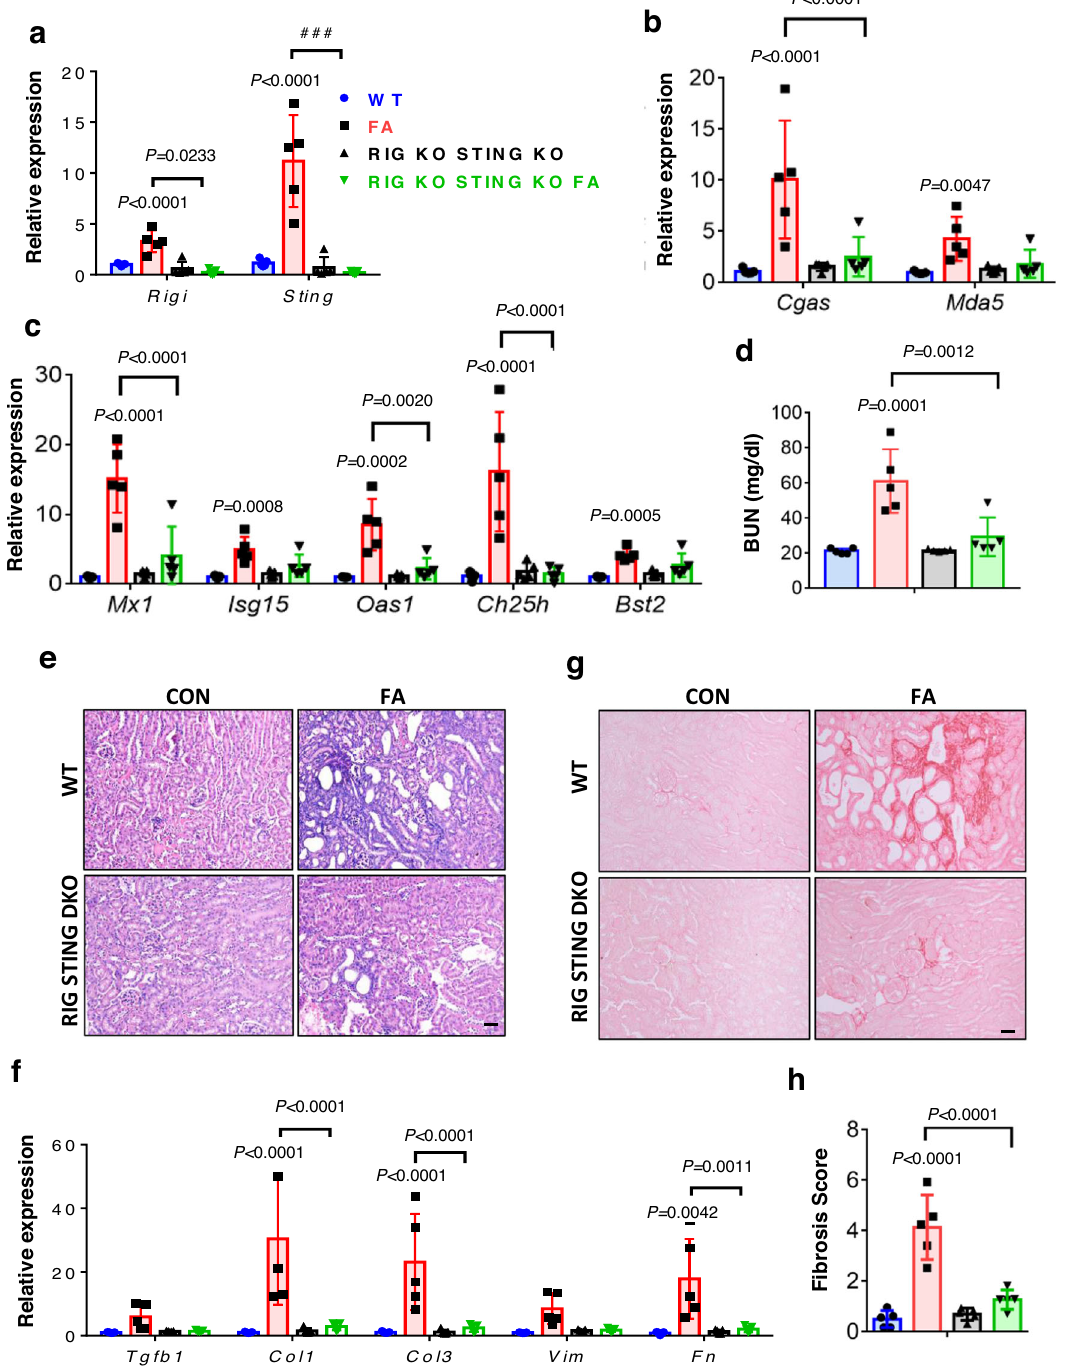
Fig. 8 | RIG KO STING KO (Double KO) mice were protected from FA-induced injury. a Relative mRNA levelsof Rigi and Sting in kidneys of WT(vehicle, blue;FA, red)andRIGKOSTINGKOmice(vehicle,black;FA,green)injectedwithFA( n =5in each). b Relative RNA levels of other cytosolic RNA sensors ( Cgas , and Mda5) in kidneysofWTandRIGKOSTINGKOmiceinjectedwithFA( n =5ineach). c Relative mRNAlevelofISGs( Mx1,Isg15,Oas1,Ch25h ,and Bst2 )inkidneysofWTandRIGKO STING KOmiceinjected with FA( n =5 in each). d Serum BUN levelsofWT and RIG KOSTINGKOmiceinjectedwithFA( n =5ineach). e RepresentativeimagesofH&E staining of kidney sections from WT and RIG KO STING KO mice injected with FA.